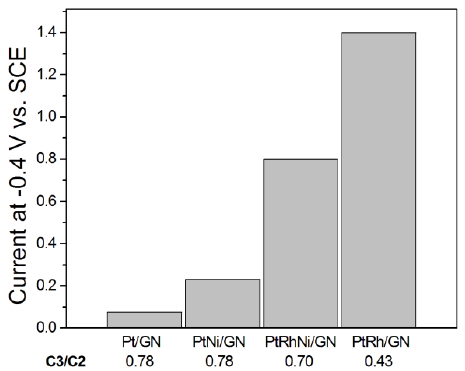
Figure 5. Histogram of the current density at −0.4 V vs. SCE for Pt/CNS, binary PtNi/GNS and PtRh/GNS, and ternary PtRhNi/GNS catalysts with different selectivity from the data of Zhou et al. [52].